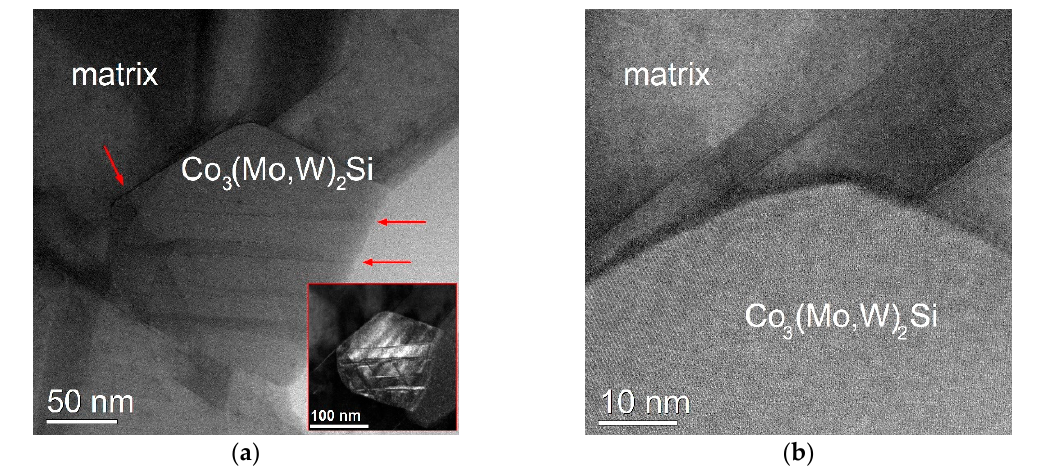
Figure 6. SAED electron diffraction of Co 3 (Mo,W) 2 Si in the direction ( a ) [001]; ( b ) [10 − 1]; and ( c ) [210]. ( d ) Model of Co 3 W 2 Si unit cell.